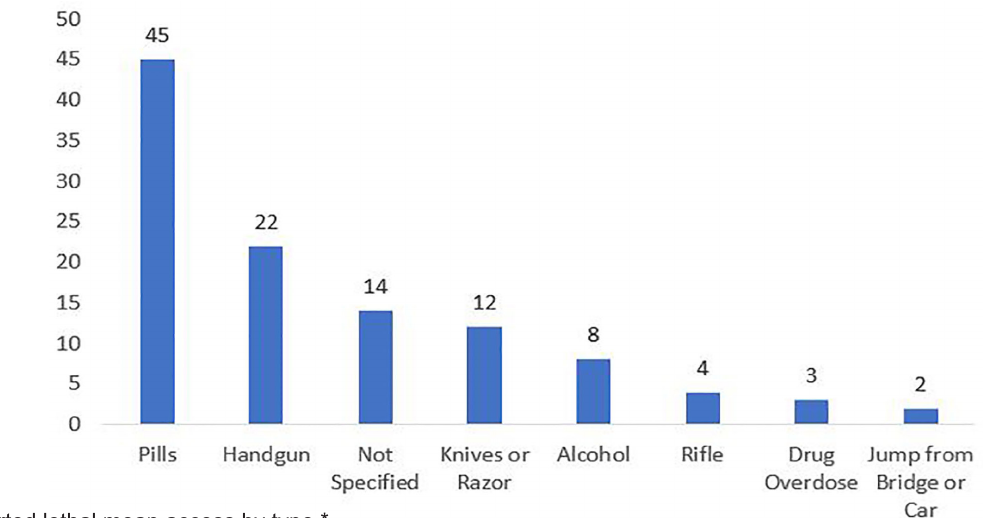
Figure 2. Reported lethal mean access by type.* *some patients reported access to more than one lethal mean.